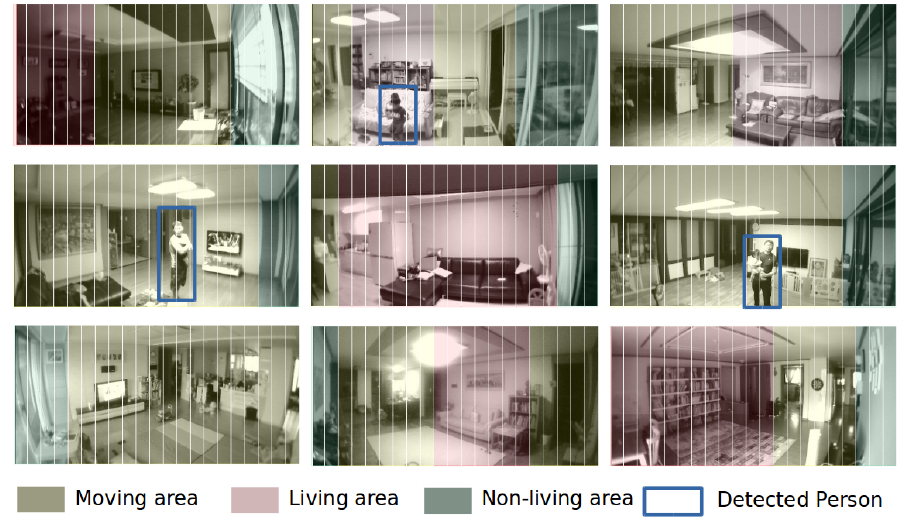
Figure 2. Human detection and Living area